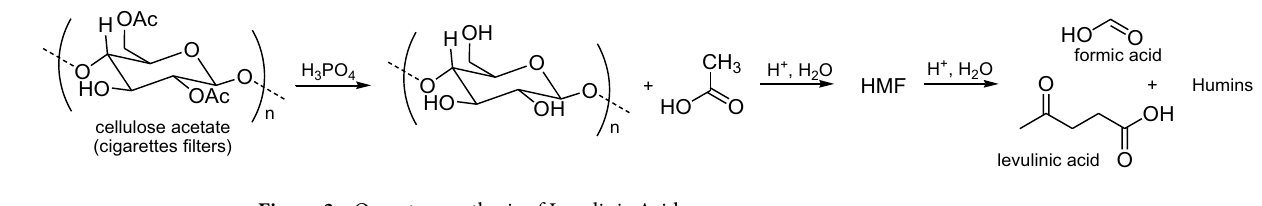
Figure 3. One-step synthesis of Levulinic